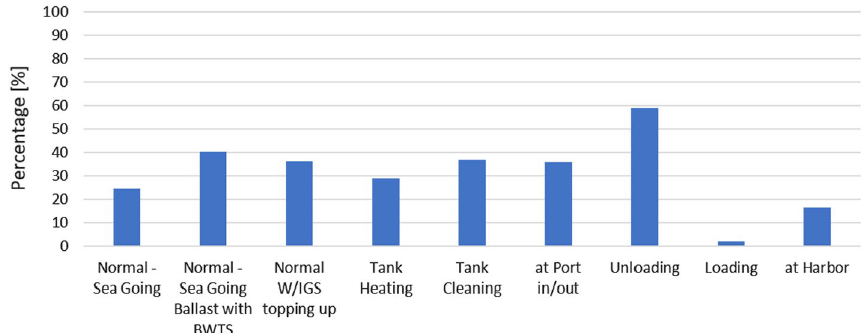
Fig. 2 Electric load analysis of a Suezmax tanker, averages per operation